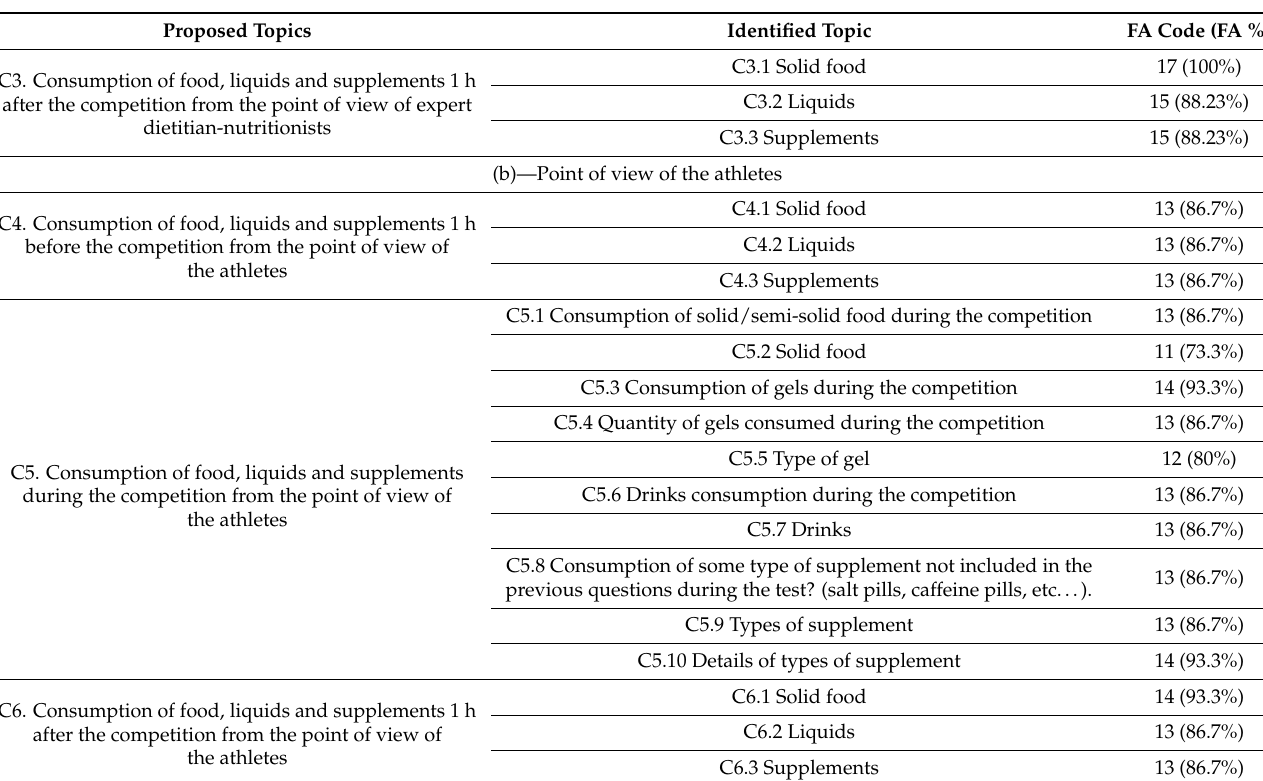
Table 4. Results of the focus groups for the content of part IV of the questionnaire, related